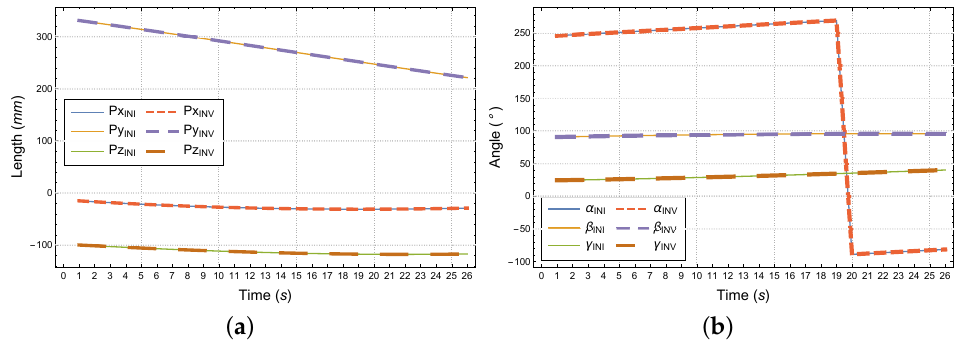
Figure 15. Position and orientation synchronization simulations between an upper-limb exoskeleton and virtual object. ( a ) Comparison between initial position and forward kinematics equations by using inverse kinematics ( P X , P Y , P Z ). ( b ) A comparison between the initial orientation and orientation equations using inverse kinematics ( α , β , γ